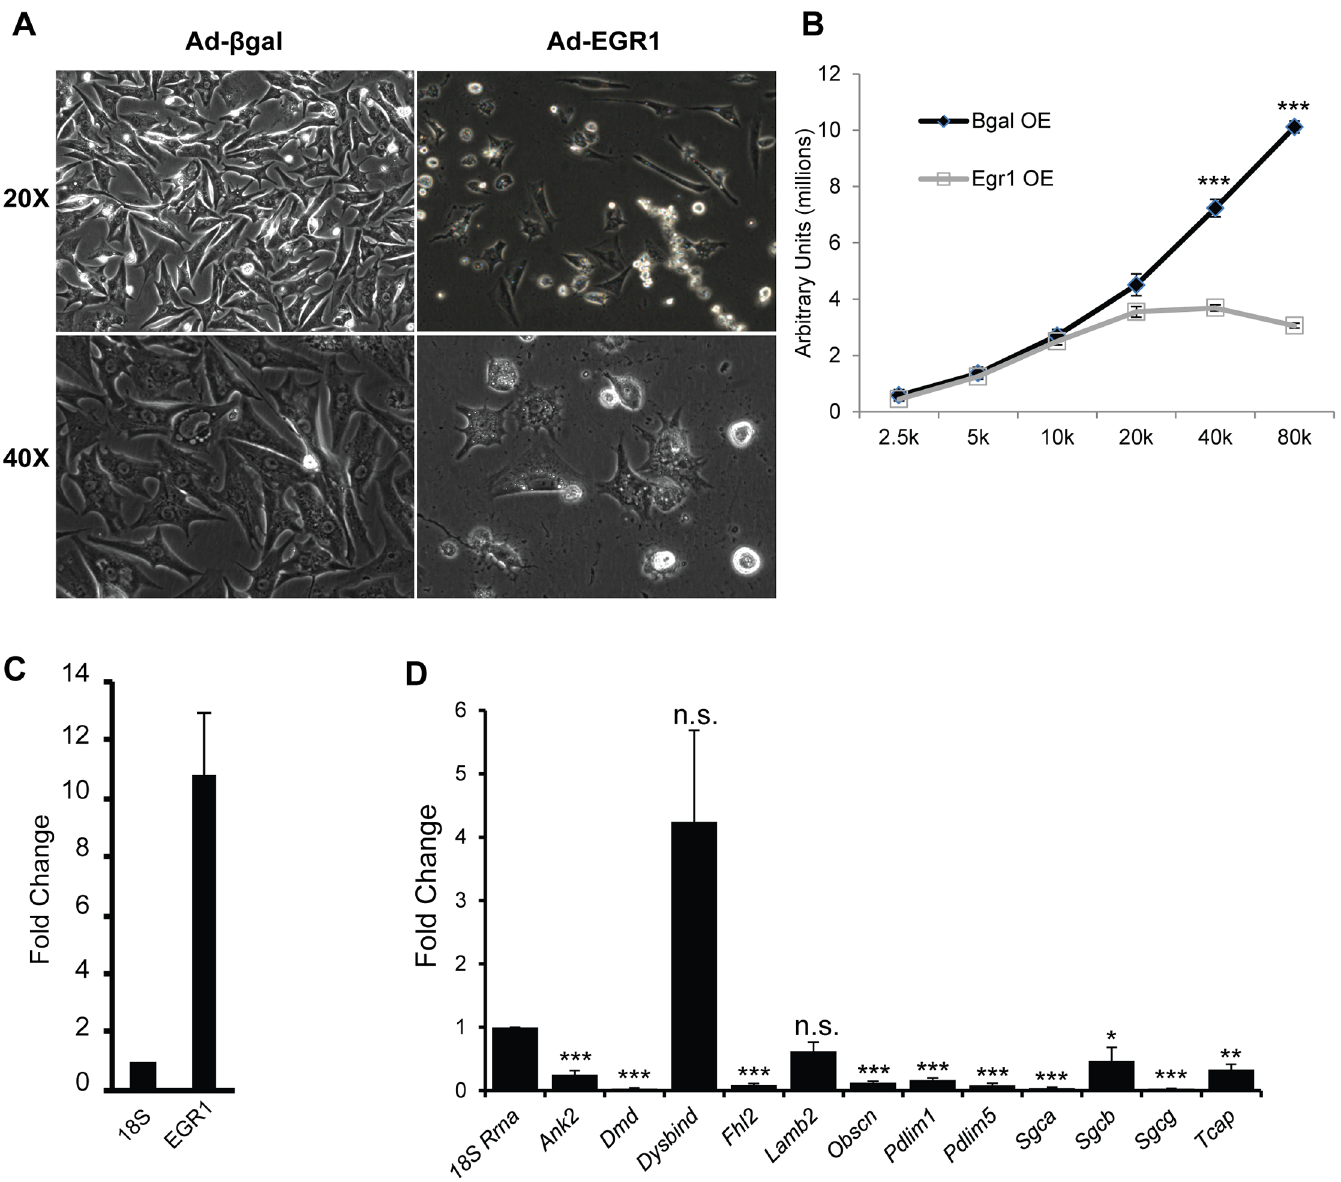
Fig 4. Costamere gene expression is sensitive to EGR1 levels in NRVMs. (A) qRT-PCR analysis confirms increased expression of Egr1 transcripts 48 hours post-transduction with AdEGR1; fold change is in comparison to expression levels in the Ad β gal control, results were normalized to 18s. (B) NRVMs were transduced with AdEGR1 and Ad β gal at an MOI of 25 and observed 48 hours post transduction. Extensive cell detachment is seen in the AdEGR1 transduced NRVMs in comparison to the Ad β gal transduced NRVMs. (C) NRVMs were seeded in increasing cell densities and transduced with AdEGR1 or Ad β gal at an MOI of 25 and assayed for cell viability 48 hours post-transduction. Cell titer blue assay shows a significant decrease in viability in AdEGR1 transduced NRVMs but not the control. (D) NRVMs were transduced with AdEGR1 or Ad β gal at an MOI of 25 and assayed for Caspase 3 activity 72 hour post-transduction. The assay shows significant upregulation of Caspase 3 activity at 72 hours post-transduction in the AdEGR1-transduced, but not Ad β gal- transduced NRVMs. (E) qRT-PCR analysis of 13 MEF2-dependent costamere genes shows 11 of these genes are down-regulated when EGR1 is overexpressed in NRVMs; fold change is in comparison to expression levels in the Ad β gal control. Results were normalized to 18s. Data are mean ± SEM, n = 3, * p < 0.05, ** p < 0.01, *** p <